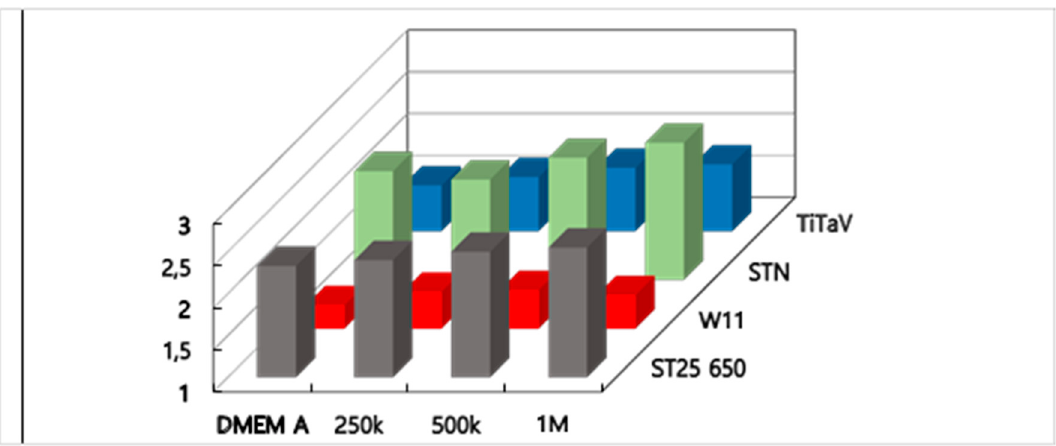
Figure 2. 3D Histogram of the responses of four different sensors to cell sample exhalations with different initial plating concentrations 250k, 500k and 1